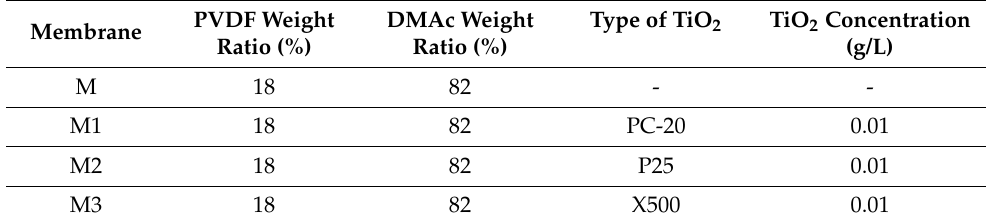
Table 2. Membrane polymer solution and coagulation bath